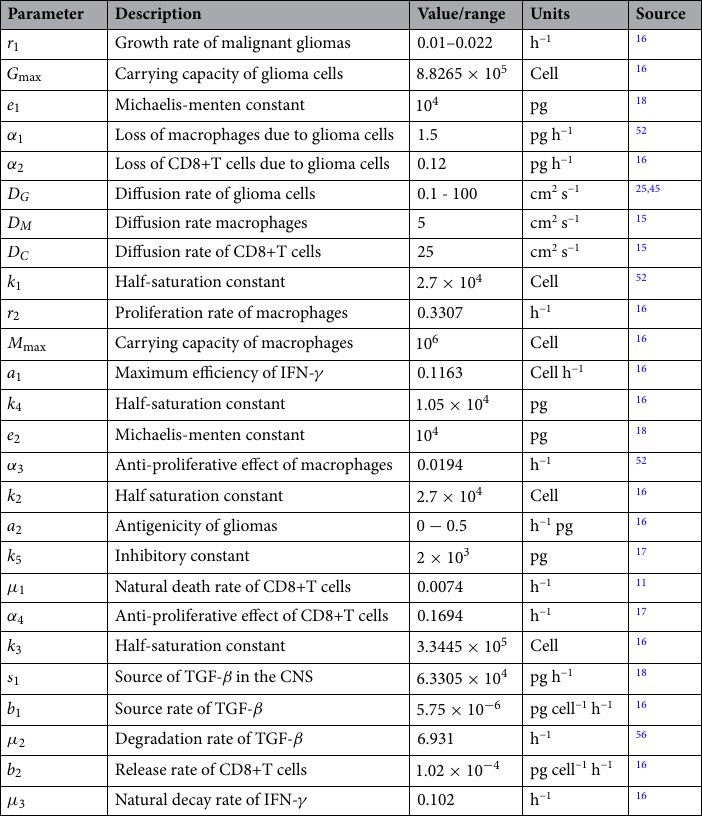
Table 1. Description of the parameter values used for computer